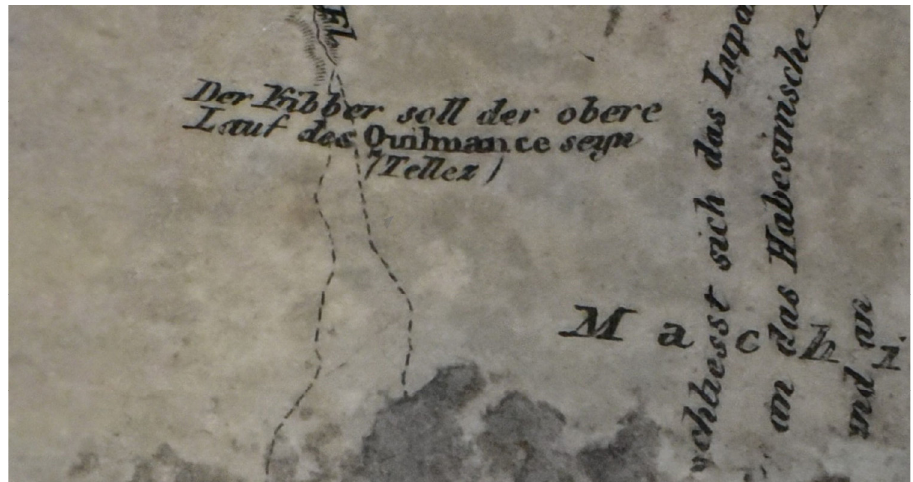
Figure 12. The detailed descriptions of contemporary German geographical names. Source: Map Collection of the Faculty of Science, Charles University.